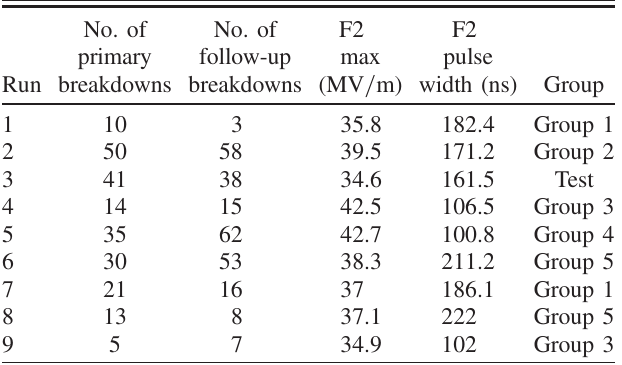
TABLE I. Information about different runs during which the operational setting was stable. Due to the limited amount of breakdowns, groups with similar F2 pulse width are formed for validation and testing during the modeling phase.